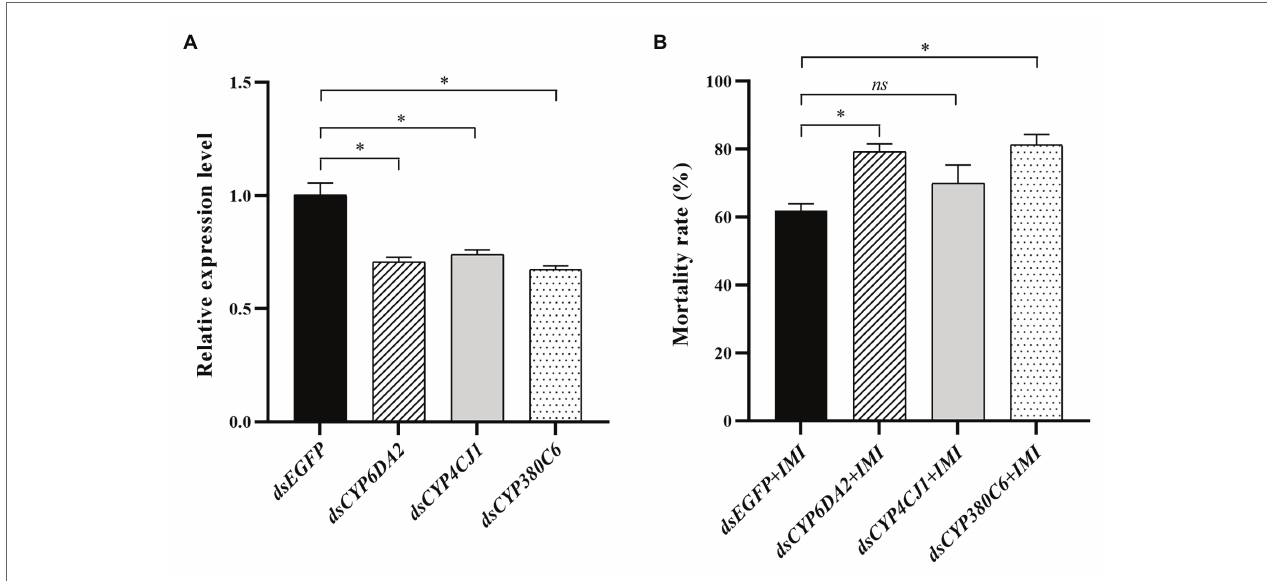
FIGURE 7 | The dsRNA-mediated suppression of P450 genes and effects on imidacloprid toxicity in A. craccivora SUS strain. (A) The dsRNA-mediated suppression the expression of three P450 genes in A. craccivora SUS strain fed on the artificial diet with dsRNA. (B) The mortality of A. craccivora strain with LC 50 dose of imidacloprid treatment after knockdown of CYP6DA2 , CYP4CJ1 , and CYP380C6 . The significant differences were marked by asterisks. *Significantly at 0.05 level. The ns represents no significant difference. IMI,